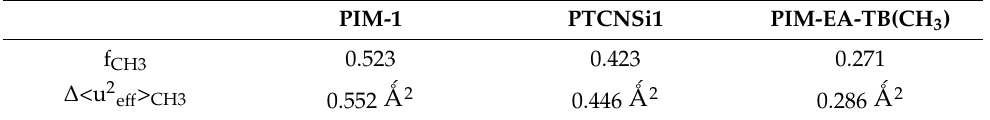
Table 2. Relative scattering cross-section of the methyl group f CH3 and contribution of the methyl groups to the effective mean squared displacement ∆ <u 2 eff > CH3 .